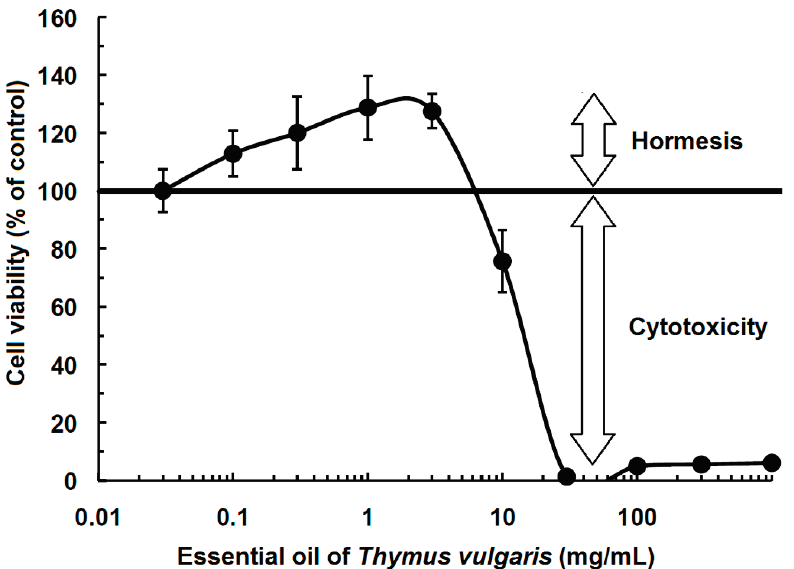
Figure 1. Hormetic effect of essential oil obtained from Thymus vulgaris cell viability (taken and modified with permission of the International Institute of Anticancer Research, Greece). Human UMSCC1 squamous cell carcinoma cells were treated with and without essential oil of Thymus vulgaris and subjected to transcriptome-wide microarray